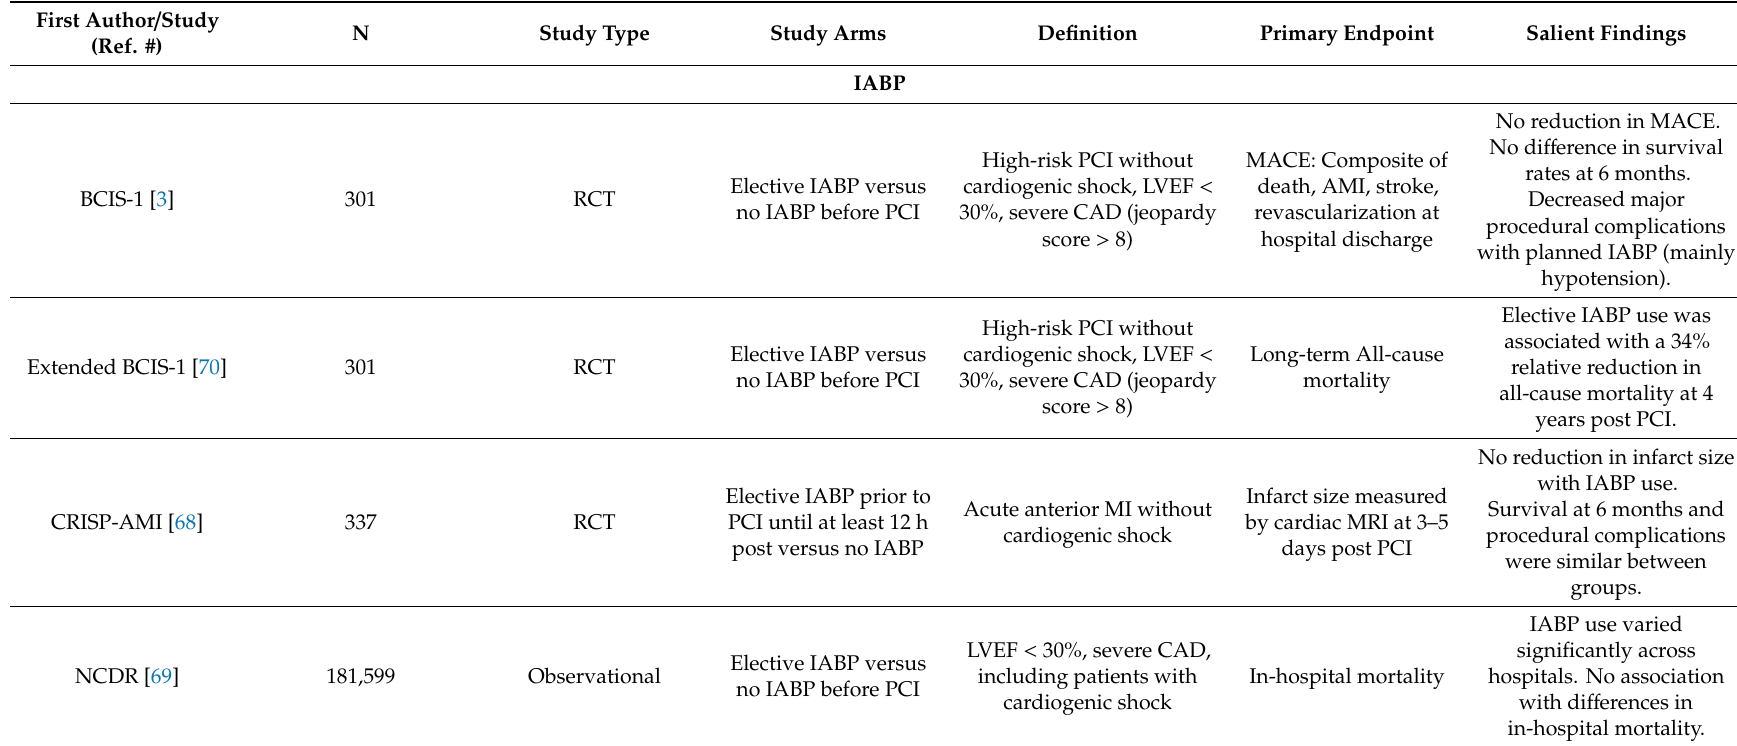
Table 4. Main Clinical Studies of Percutaneous MCS devices in High-Risk